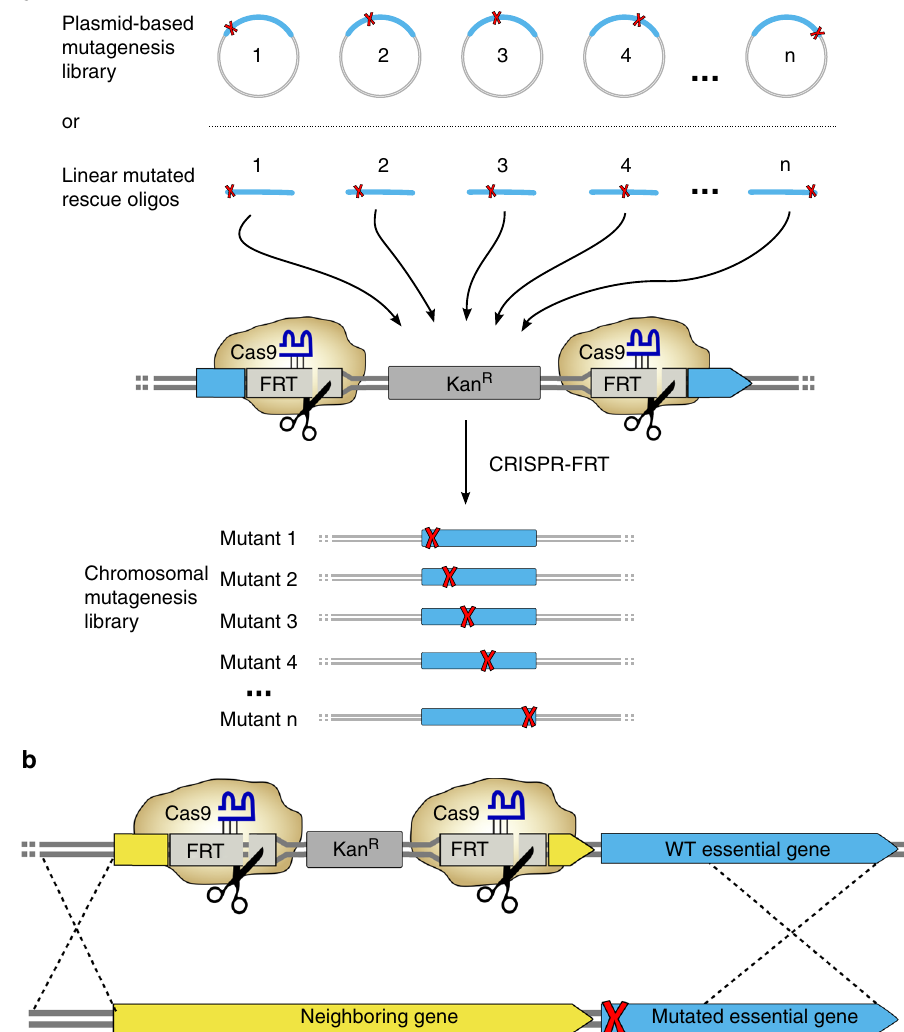
Fig. 2 Extended applications of CRISPR-FRT. a Members of a plasmid-encoded mutagenesis library (1 – 4 … n ) or PCR-ampli fi ed linear fragments containing multiple mutated versions of one gene can serve as rescue DNA and thereby be transferred to the chromosome. This allows for single-step transfer of a mutagenesis library to the genome or reconstruction of multiple mutations (red X) in the same gene by only using a single pair of PCR primers to generate the different rescuing templates that contain the desired mutations. b Mutations in essential genes can be delivered to Keio strains with Kan R cassettes inserted into the closest neighboring non-essential gene if recombination (dashed lines) occurs beyond